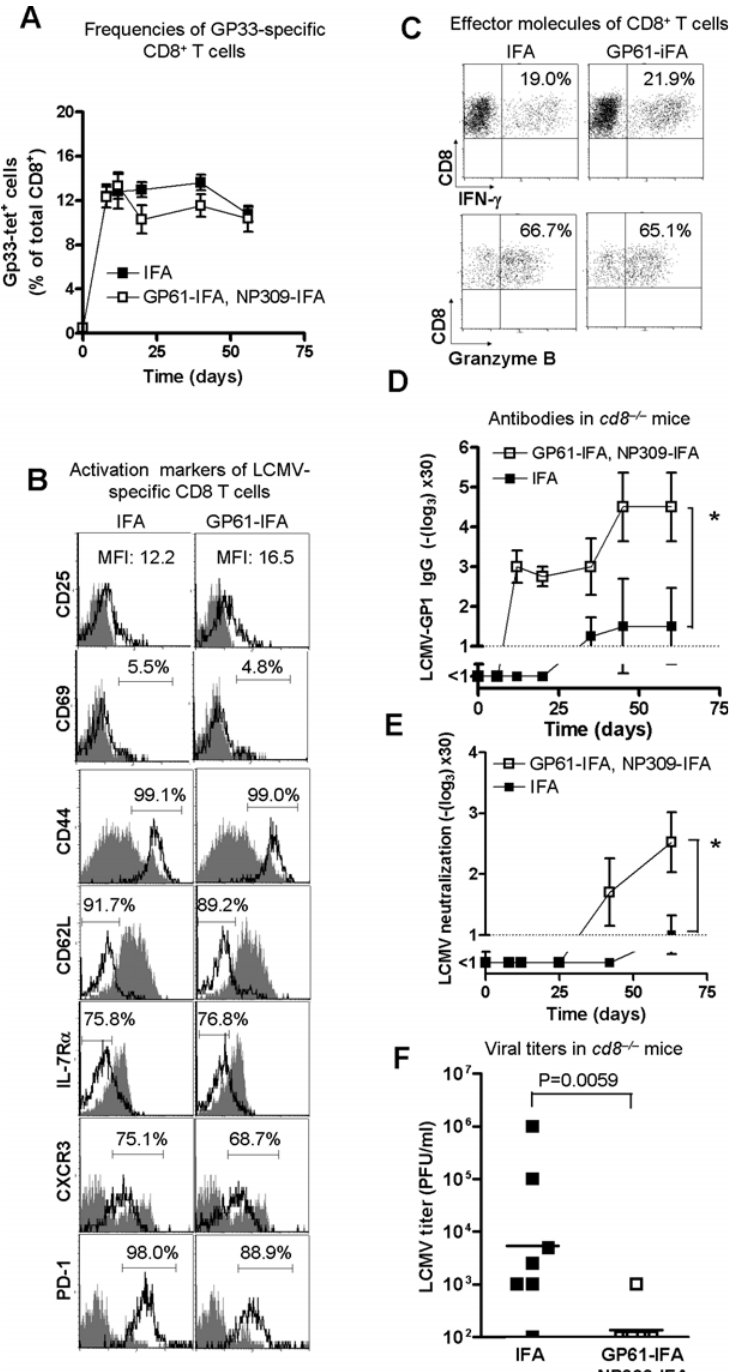
Figure 3. Peptide tolerisation improves protective antibody responses independently and without impairment of CD8 + T cells. A: C57BL/6 mice were treated with GP61-IFA and NP309-IFA, while control mice were treated with IFA alone at days -9, -6, -3. At day 0 mice were infected with 200pfu LCMV-WE, and GP-specific (tet-gp33 + ) CD8 + T cells were analyzed in the blood by FACS analysis (n=4, ns). B + C: 5 6 10 4 splenocytes from mice transgenic for a T cell receptor recognizing the LCMV helper epitope GP61 (LCMV-glycoprotein 61-80 /I-A b -specific TCR, SMARTA mice) and for the T cell marker Thy1.1 were transferred into C57BL/6 mice on day -10. One group of mice was treated with 100 m g GP61 dissolved in IFA, while control mice were treated with IFA alone at days -9, -6, -3. At day 0 mice were infected with 200pfu LCMV-WE or left untreated. GP33 specific CD8 + T cells were analyzed for frequencies (Figure S3) and for the expression of the activation markers CD25, CD69, CD44, CD62L, IL-7R a , CXCR3 and PD-1 (1 of 4 histogram plots is shown, grey area represents staining of naı¨ve CD8 + T cells, B). CD8 + T cells were analyzed for expression of the intracellular effector molecules IFN- c and Granzyme B after restimulation (1 of 4 dot plots is shown, C). D–F: cd8 2 / 2 mice were treated with GP61/NP309-IFA or with IFA alone on days -9, -6 and -3. On day 0 mice were infected with 200pfu LCMV-WE and LCMV-GP1 specific IgG antibodies were detected by ELISA (n=3– 4, *p=0.03, D) and by neutralisation assay (n=7–8, *p=0.04, E) at the indicated time points. Virus blood titers were measured with plaque assay on day 35 after LCMV infection as indicated (n=7–8, p=0.0059, F).